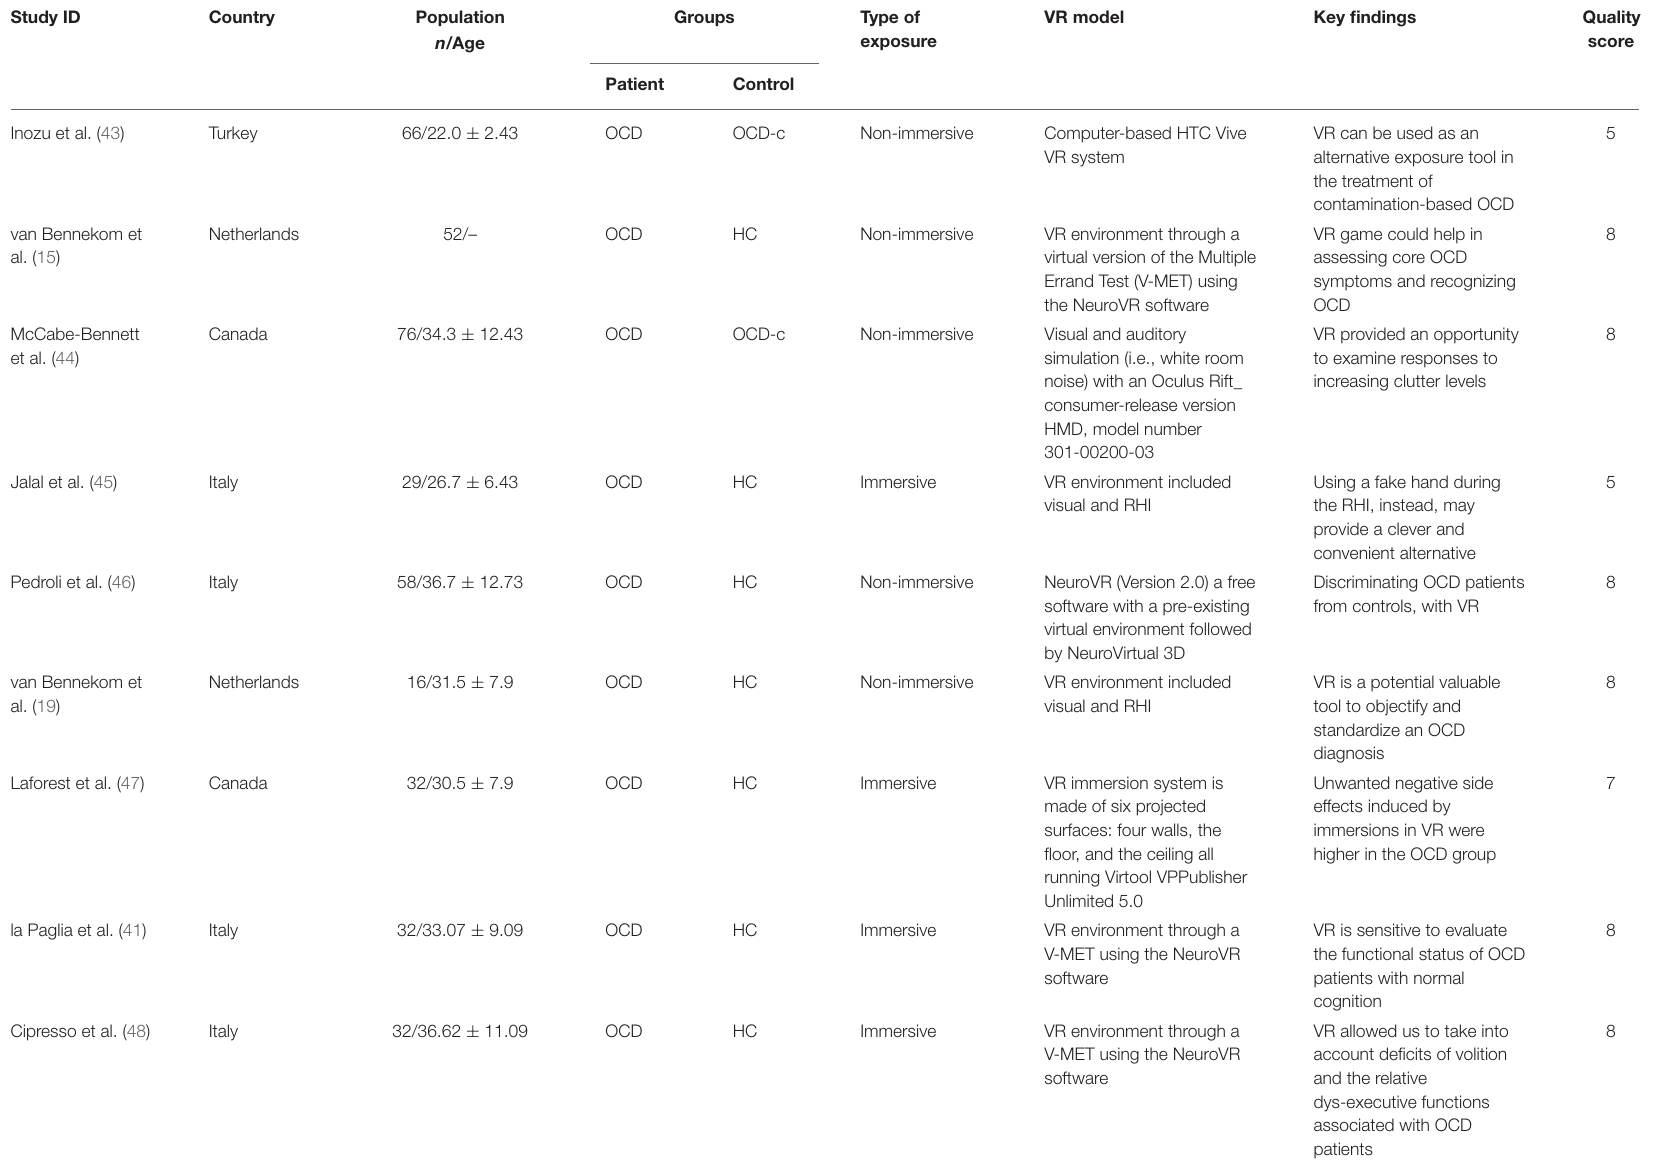
TABLE 2 | Characteristics and results of included studies that report on the effectiveness of virtual reality on emotional and symptoms in patients with